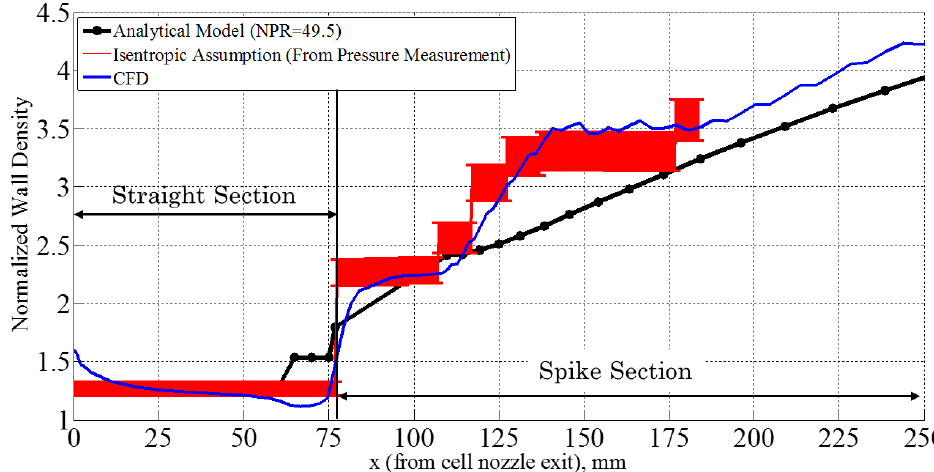
Figure 11. Comparison of spike wall density distribution among the analytical model, CFD, and isentropic estimation. The NPR was 49.5 and the external flow Mach number was 2.0.